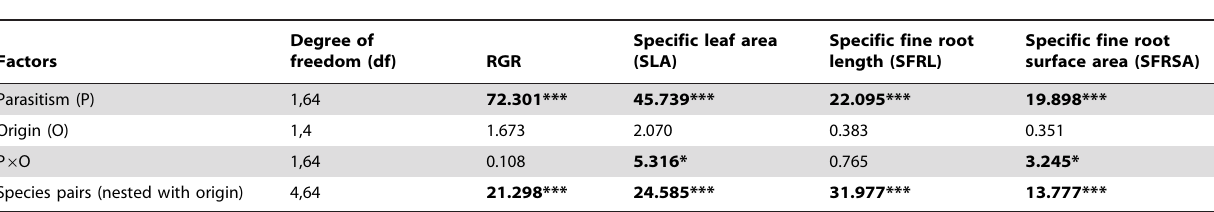
Table 1. F -values and significance levels of three-way nested ANOVAs of the relative growth rate (RGR) and the resources availability of host plants with fixed factors parasitism (present or absent) and origin (invasive or native), and random factor species pairs (nested with